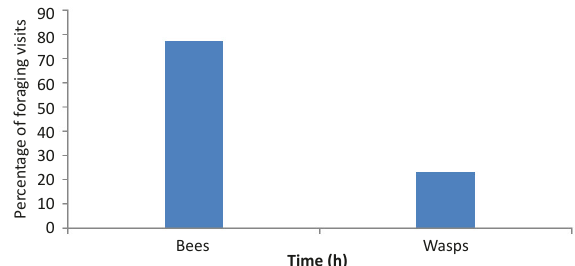
Figure 3. Percentage of foraging visits of bees and wasps on Eriolaena